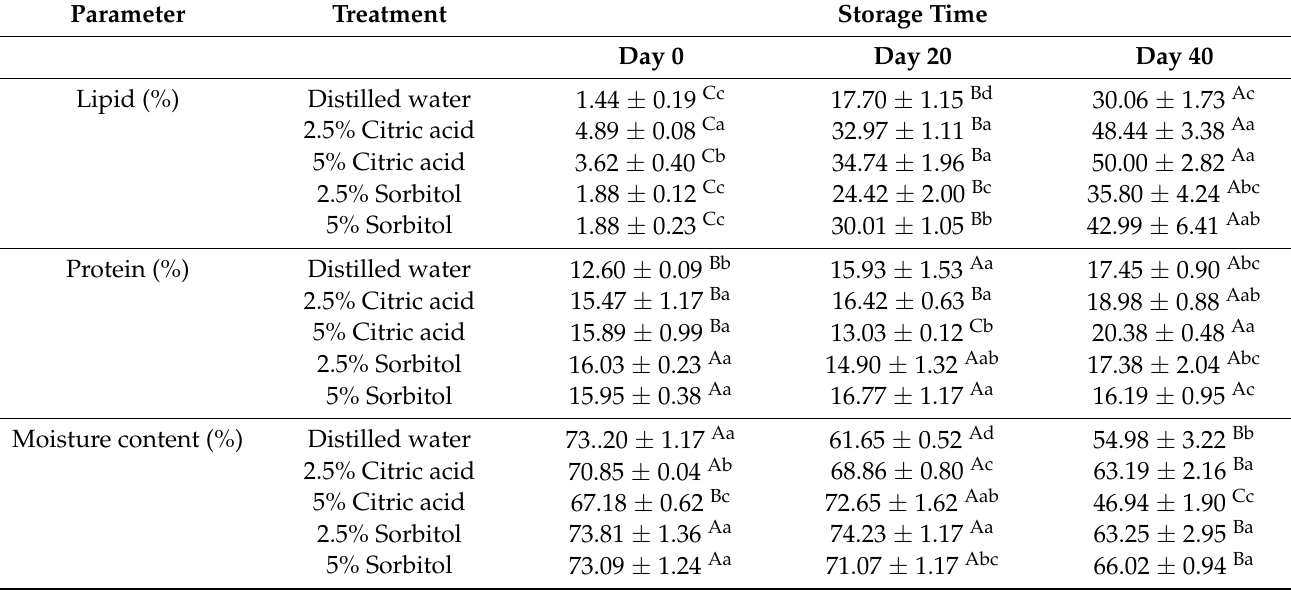
Table 1. Lipid, protein, and moisture content of frozen fish fillets soaked with different solutions after thawing during frozen storage